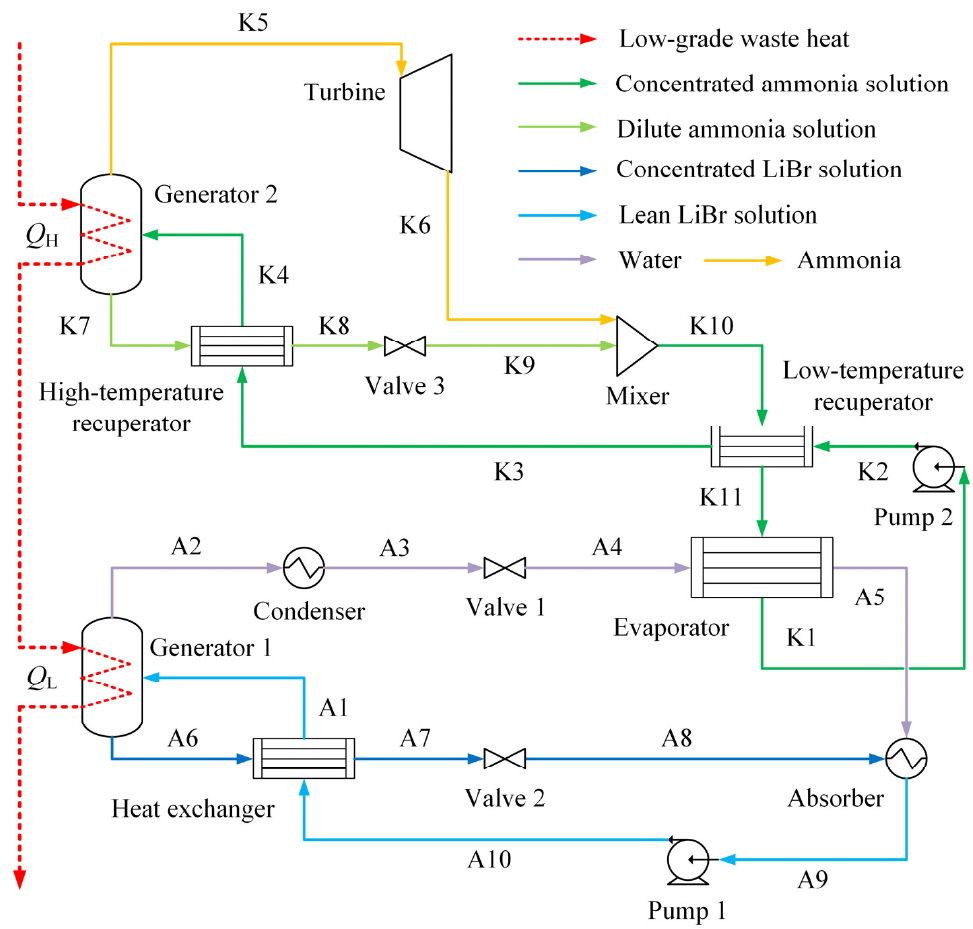
Figure 1. LiBr/H 2 O absorption chiller/KC integrated system.